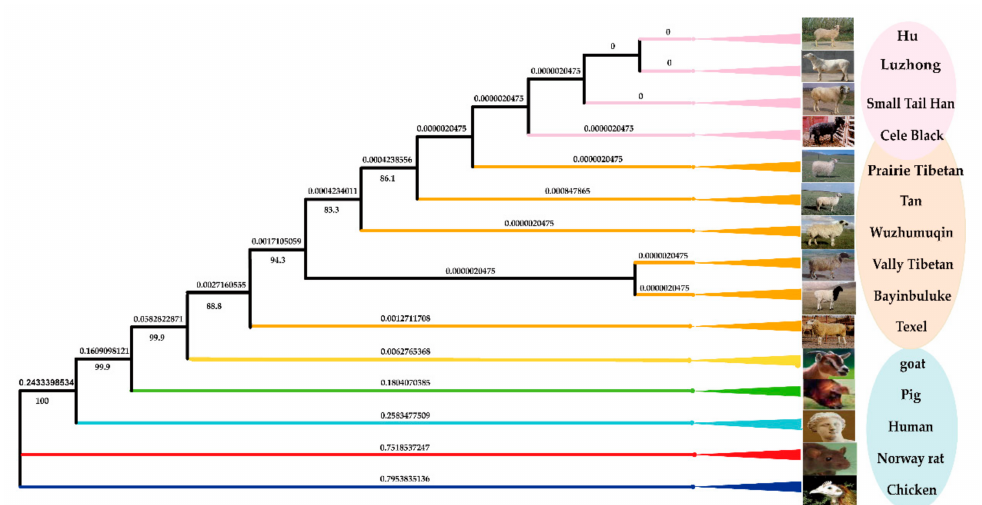
Figure 2. The phylogenetic tree of the GDF9 gene in different species. The upper values refer to branch lengths values and the lower values refer to the bootstrap values measured in the number of substitutions per site. Note: The pink circle refers to the four prolific sheep breeds (Cele Black, Small Tail Han, Hu, Luzhong). The orange circle refers to mono-lamb sheep breeds (Prairie Tibetan, Tan, Wuzhumuqin, Valley Tibetan, Bayinbuluke, Texel). The light blue circle refers to different